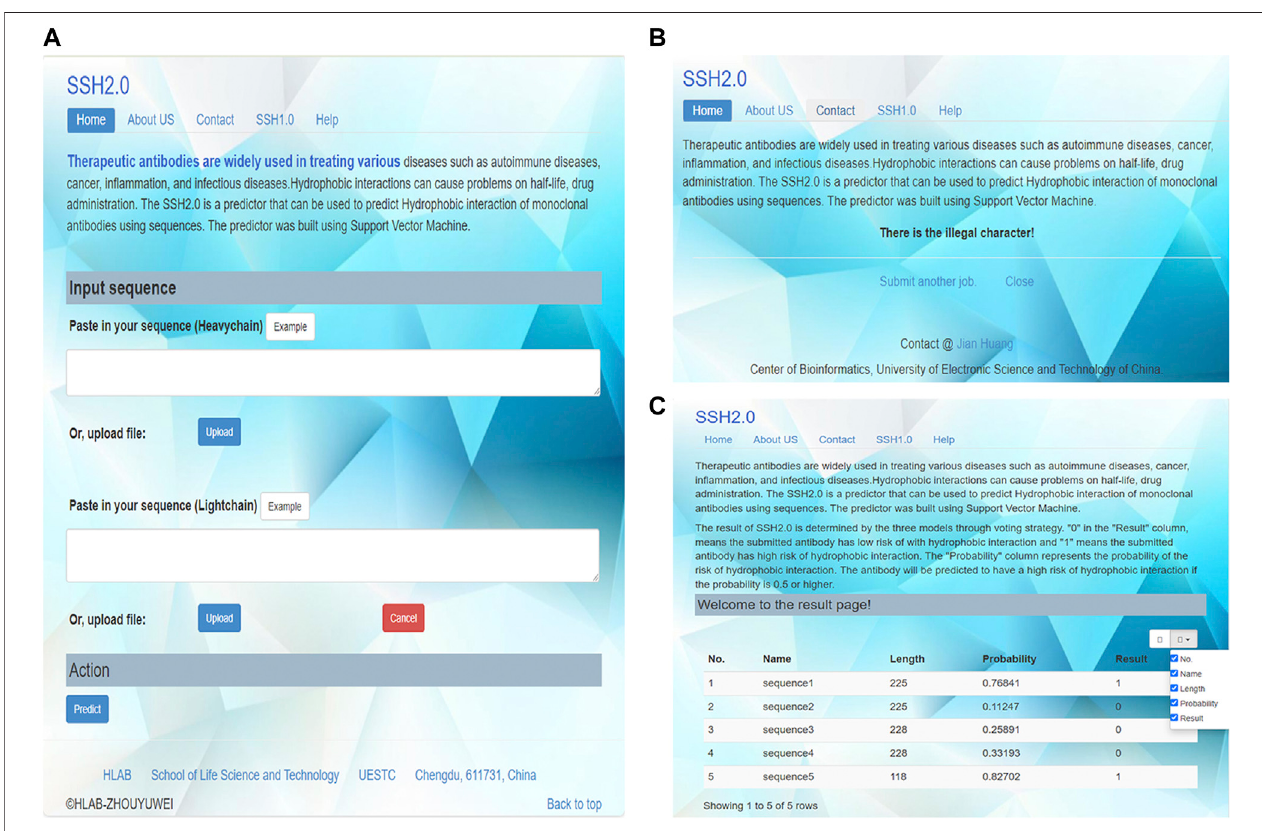
FIGURE 6 | Screenshots of the SSH2.0 web server. (A) Homepage of the SSH2.0 web server. (B) If illegal characters appear in the input sequence, click “ predict ” bottom and a prompt page will pop up, The prompt page showing “ There is the illegal character! ” . Users can click “ submit another job. ” to return to the home page and resubmitthesequence. (C) Resultdisplay page. “ 1 ” inthe “ Result ” columndenotes thatthesubmitted antibodycandidateexhibitsahigh riskofhydrophobic interaction and shouldbeexcluded from thedevelopmentpipeline. The “ Probability ” column representstheprobabilityofthe riskofhydrophobic interaction.The antibodywill be predicted to have a high risk of hydrophobic interaction if the probability is 0.5 or higher. The result table can be sorted according to each column, and a custom display box allows users to select and display speci fi c information as